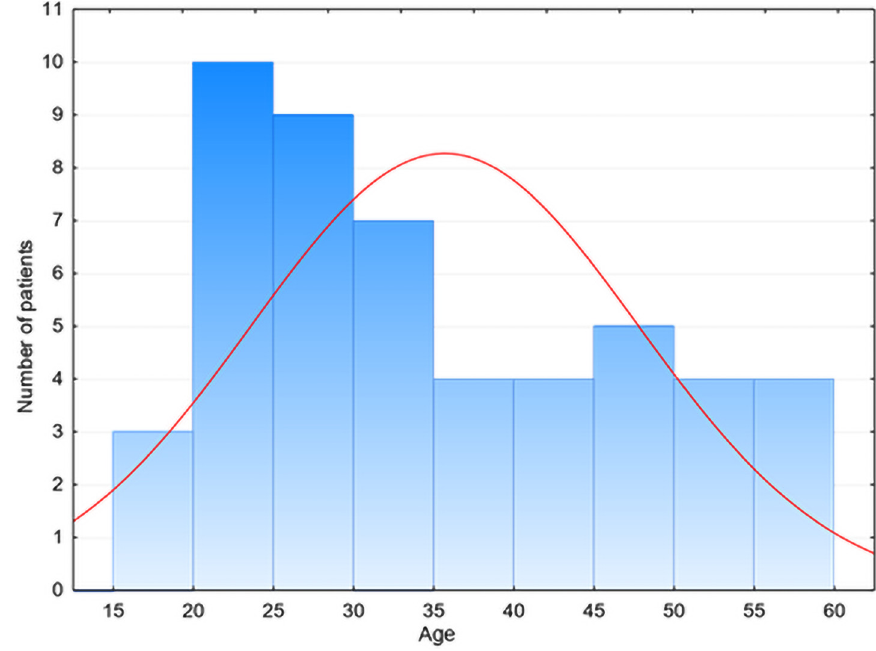
Figure 10. Age distribution in the research group.